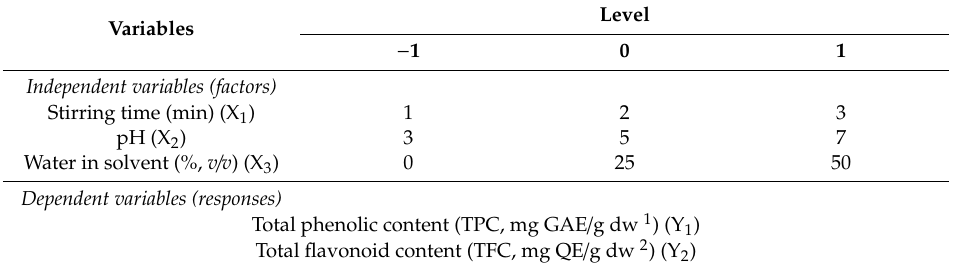
Table 1. Independent and dependent variables of the experimental design used in the screening